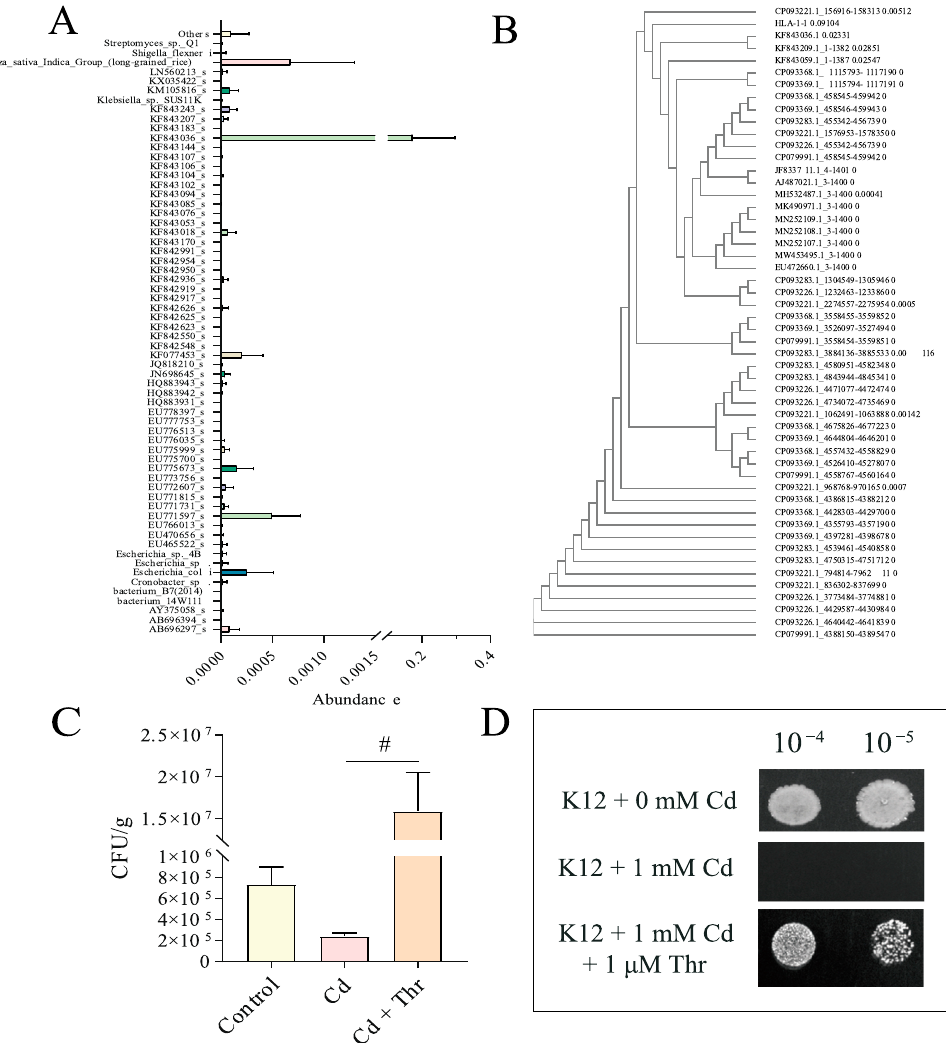
Figure 4. Identification of E. coli . ( A ) Average enumeration of E. coli in mice feces of 5 days. ( B ) Species component and the correspondent abundance of Escherichia-Shigella genus. ( C ) Phylogenetic tree of KF843036.1 with HLA-1-1 and top 50 results of Blast from National Center for Biotechnology Information (NCBI). ( D ) Sensitivities of K12 to 1 mM Cd evaluated by 1 × 10 − 3 , 10 − 4 , and 10 − 5 -fold dilution assay: K12 were spotted onto LB media. # , p < 0.05 means significantly different compared to $(cid:6)*(cid:6):9(cid:6)%&! the Cd-treated